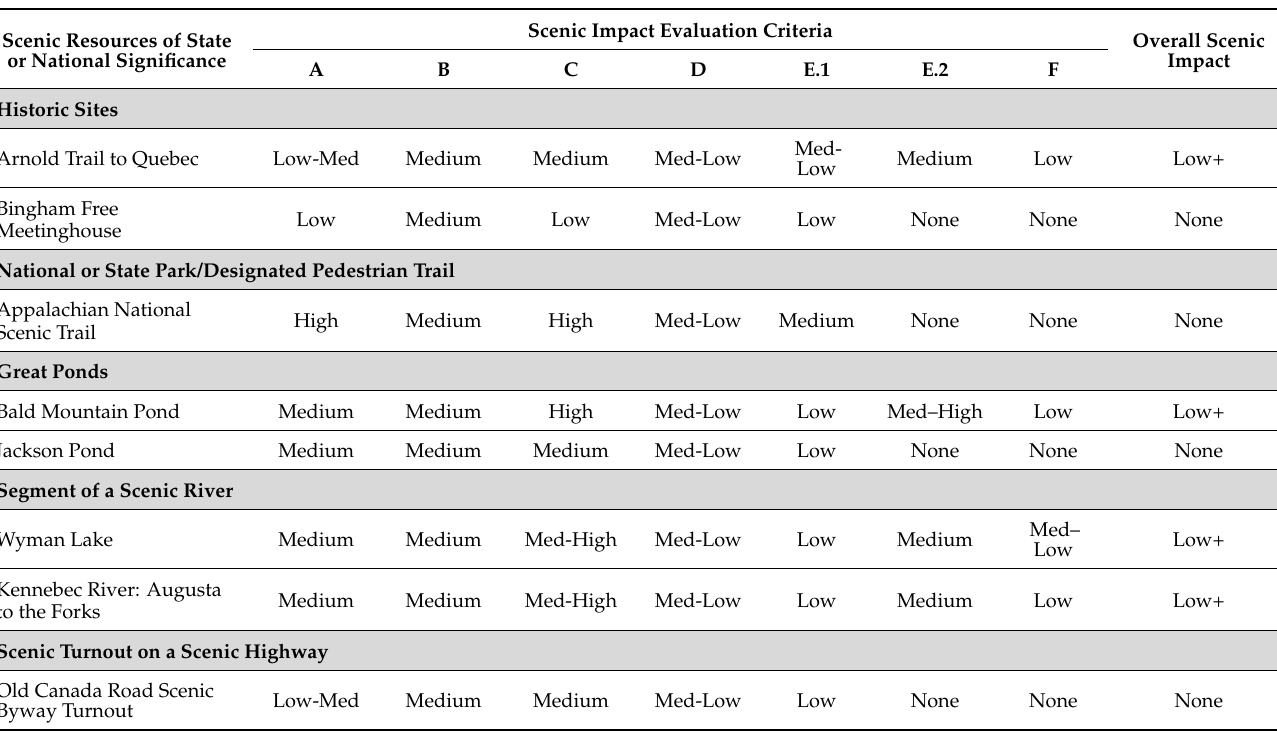
Table 4. Evaluation Criteria Rating